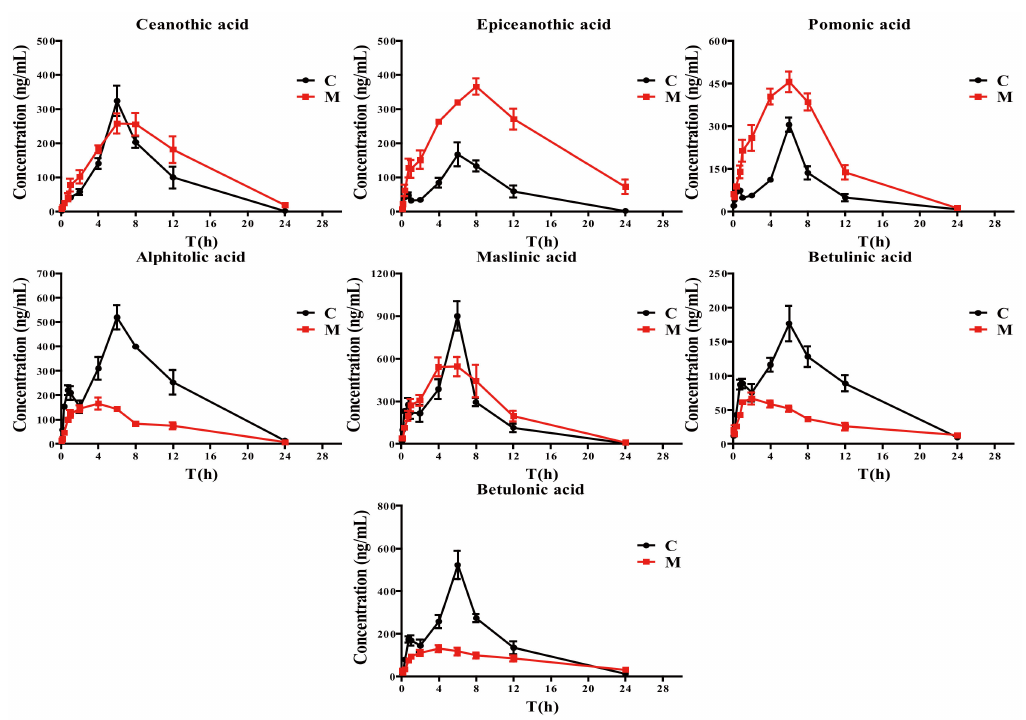
Figure 4. Mean plasma concentration–time curves of seven triterpenic acids after oral administration of TAE for control (C) and acute liver injury model groups (M) (means ± SEM, n =